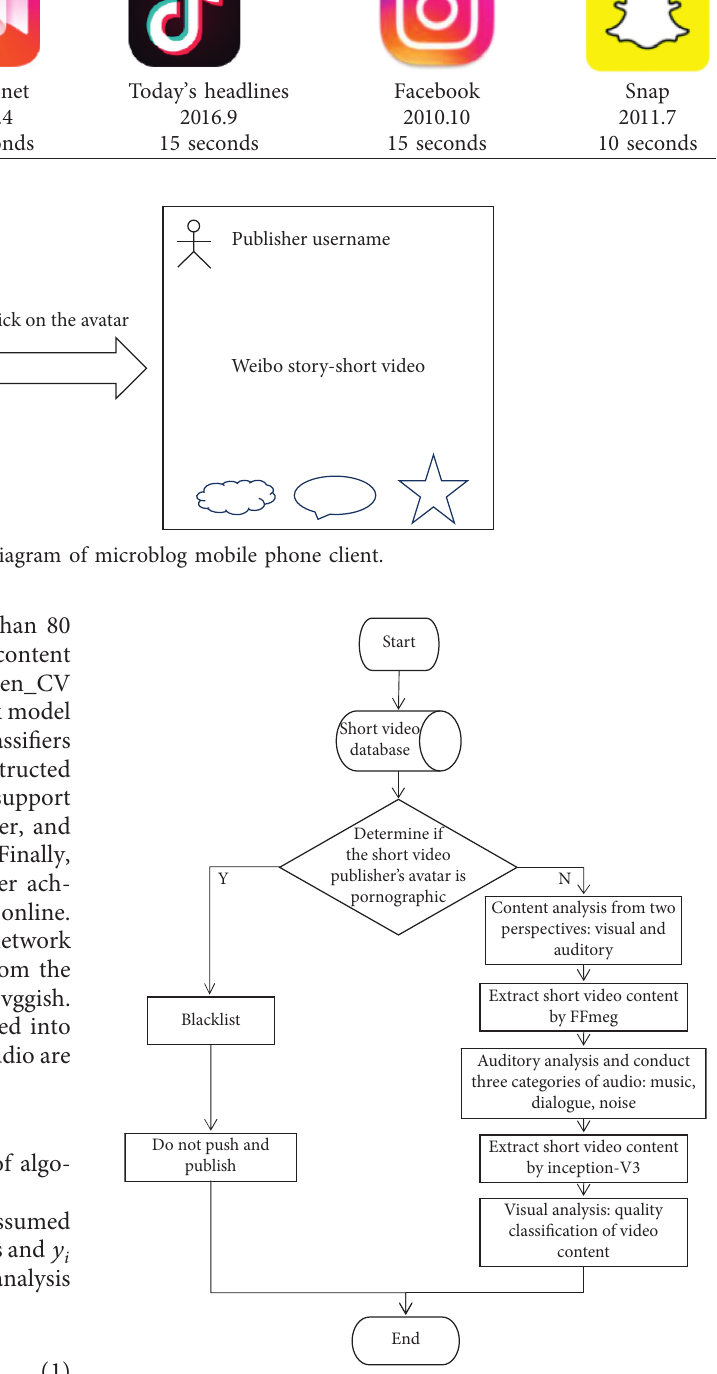
Figure 3: Flow chart of algorithm architecture